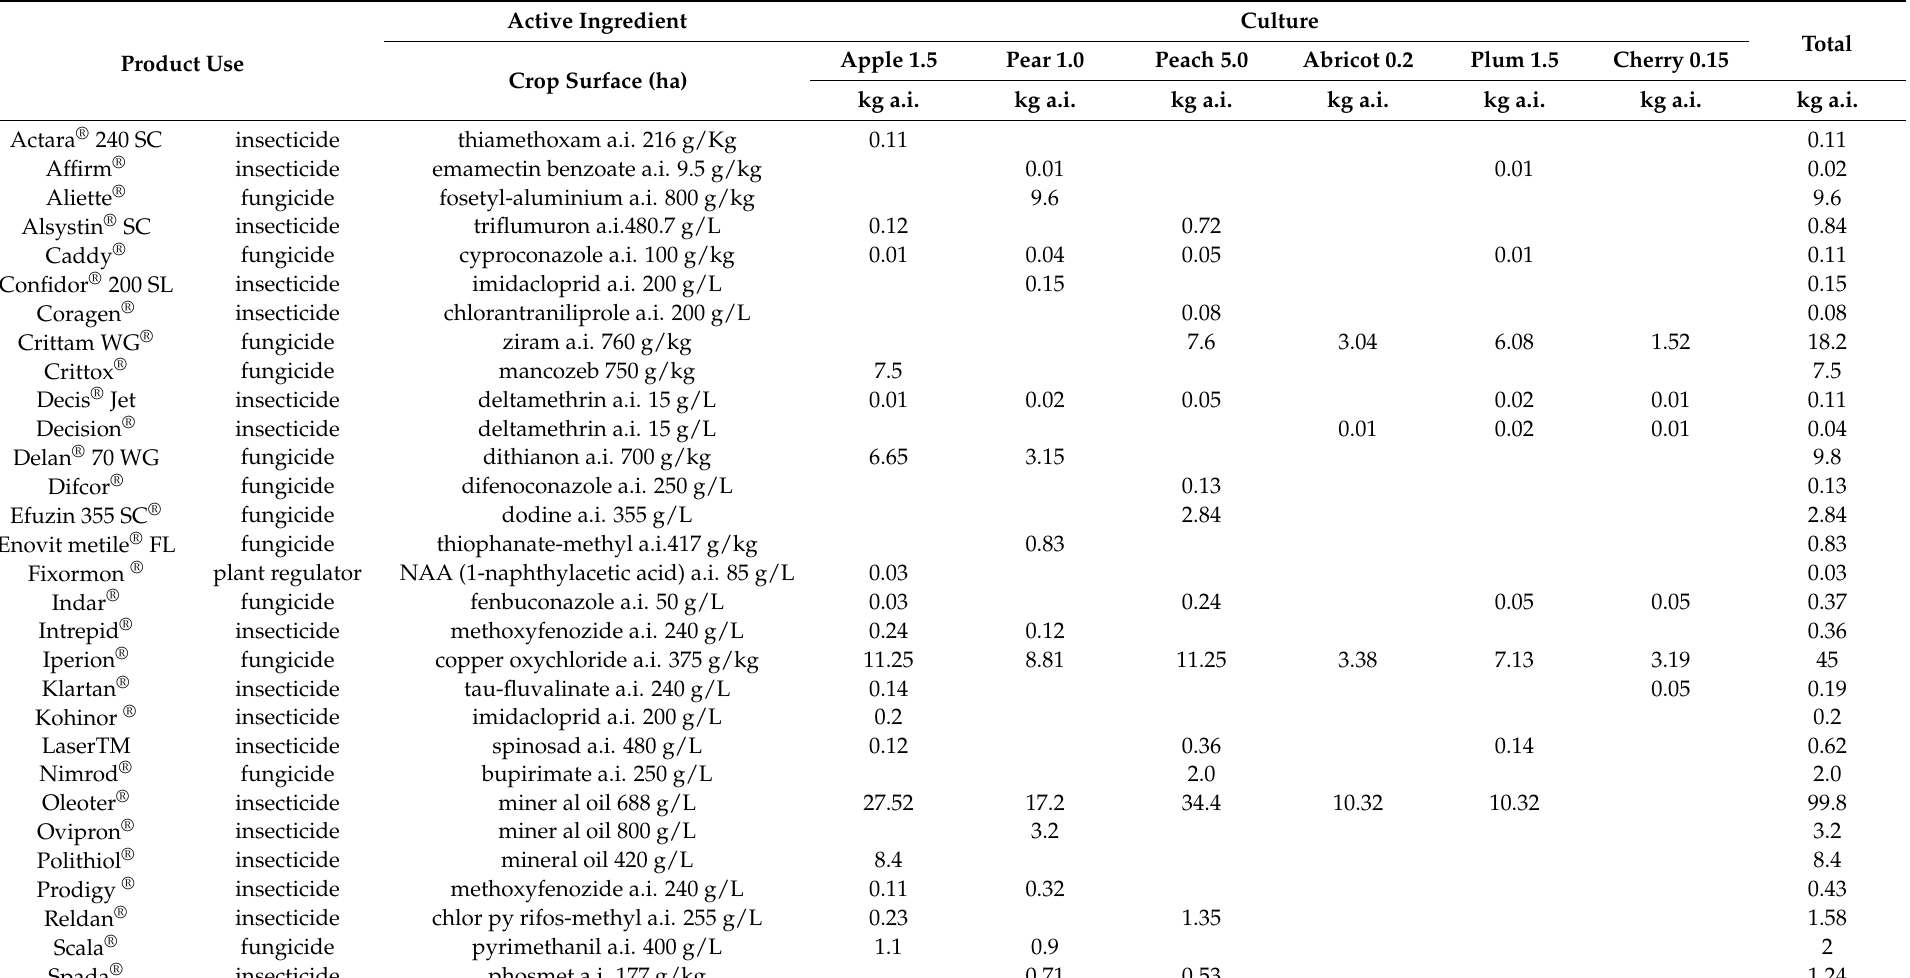
Table 2. List of commercial products (expressed as Kg a.i./hectare) in alphabetic order and their active ingredients used in 2017 in the orchard farm where exposure site was